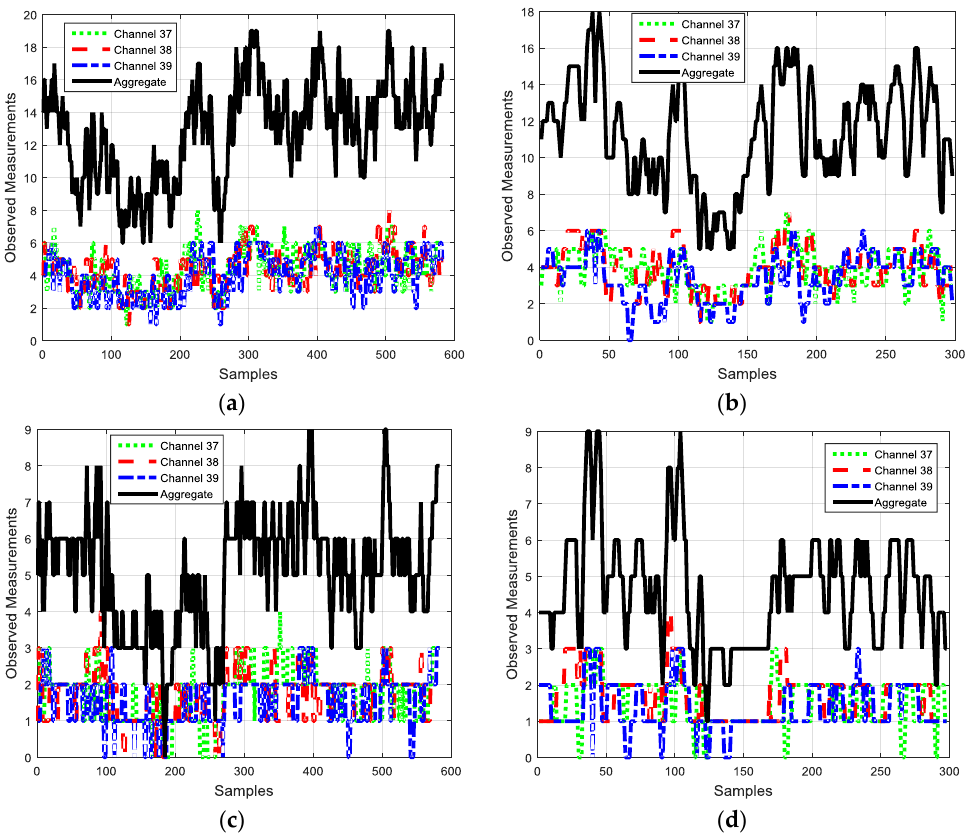
Figure 11. Numbers of observed advertisement channels of BLE beacons in two trajectories with dense and sparse deployment of BLE beacons: ( a ) Trajectory I with 20 deployed BLE beacons; ( b ) Trajectory II with 20 deployed BLE beacons; ( c ) Trajectory I with 8 deployed BLE beacons; and ( d ) Trajectory II with 8 deployed BLE beacons.